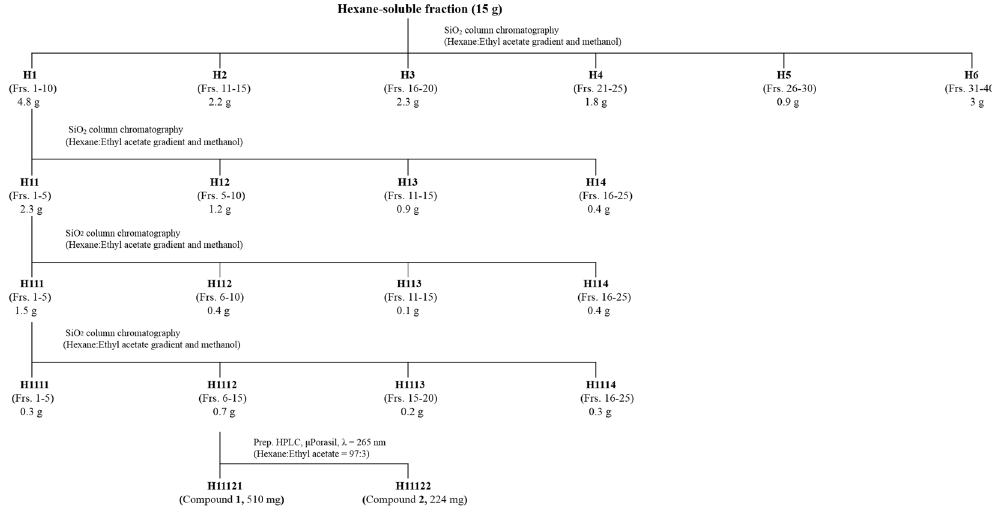
Figure 2. Procedures to isolate the repellent constituents. The Cyperus rotundus rhizome methanol extract was sequentially partitioned into hexane-, chloroform-, ethyl acetate- and water-soluble portions. The hexane- soluble fraction was the most biologically active fraction and high-performance liquid chromatography was performed. Each fraction (244.6 μ g cm − 2 ) was tested in a filter-paper choice bioassay to isolate the active compounds from the